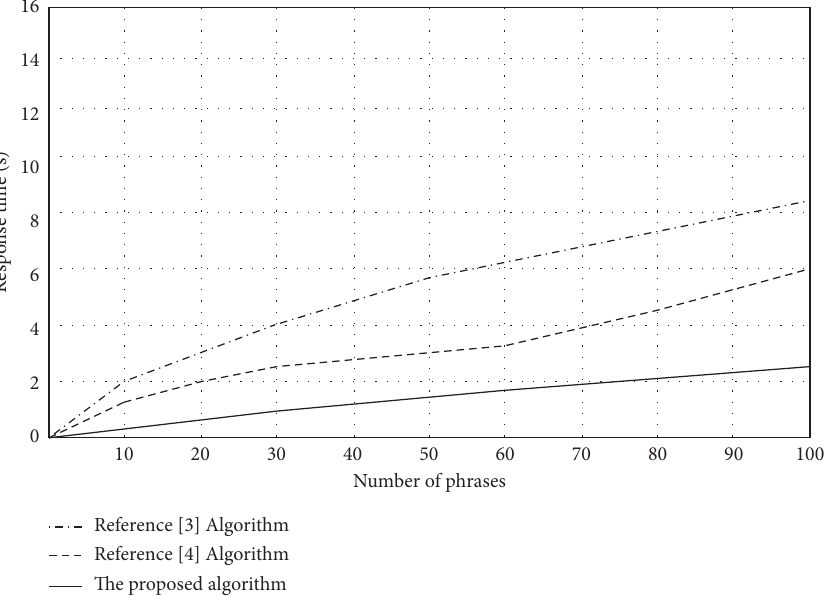
Figure 3: Comparison results of response